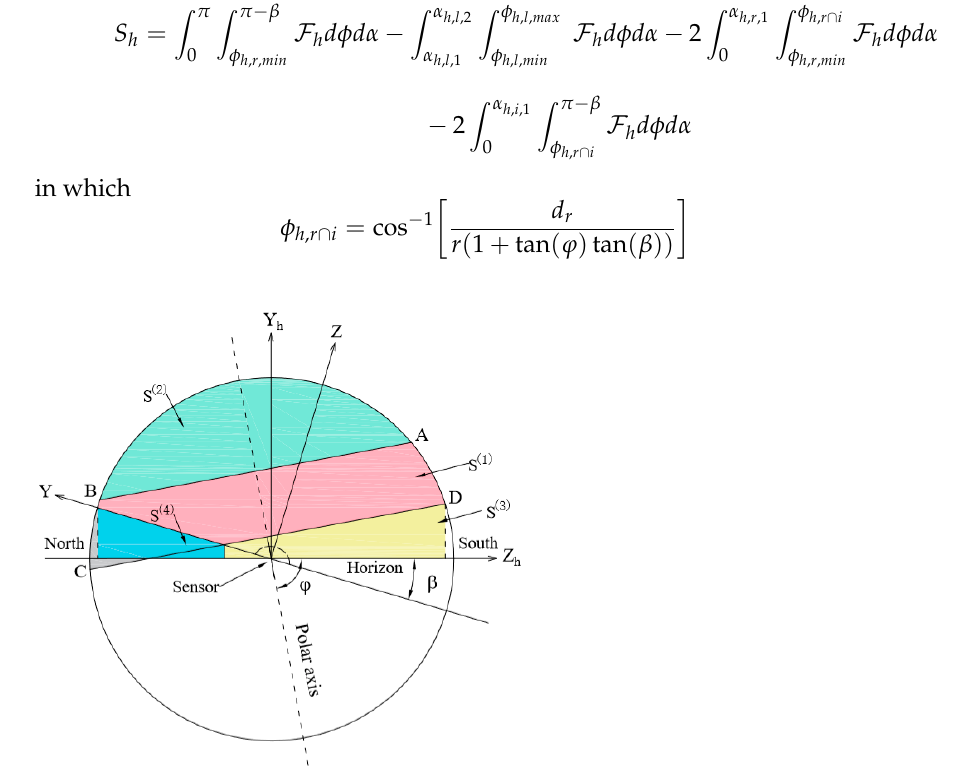
(35) Figure 12. Schematic diagram for the calculation of 𝑆 (cid:3035) while 𝑑 (cid:3045) ≤ 0 , 𝜙 (cid:3035),(cid:3039),(cid:3040)(cid:3028)(cid:3051) ≥ 𝜙 (cid:3035),(cid:3039)∩(cid:3036) ≥ 𝜙 (cid:3035),(cid:3039),(cid:3040)(cid:3036)(cid:3041) ,𝜙 (cid:3035),(cid:3045),(cid:3040)(cid:3028)(cid:3051) ≥ 𝜙 (cid:3035),(cid:3045)∩(cid:3036) ≥ 𝜙 (cid:3035),(cid:3045),(cid:3040)(cid:3036)(cid:3041) . (8) while 𝑑 (cid:3045) ≤ 0 , 𝜙 (cid:3035),(cid:3039),(cid:3040)(cid:3036)(cid:3041) > 𝜋 − 𝛽 > 𝜙 (cid:3035),(cid:3045),(cid:3040)(cid:3036)(cid:3041) , shown as Figure 13, the axis Y is be- tween the points A and D. The Equation (5) becomes